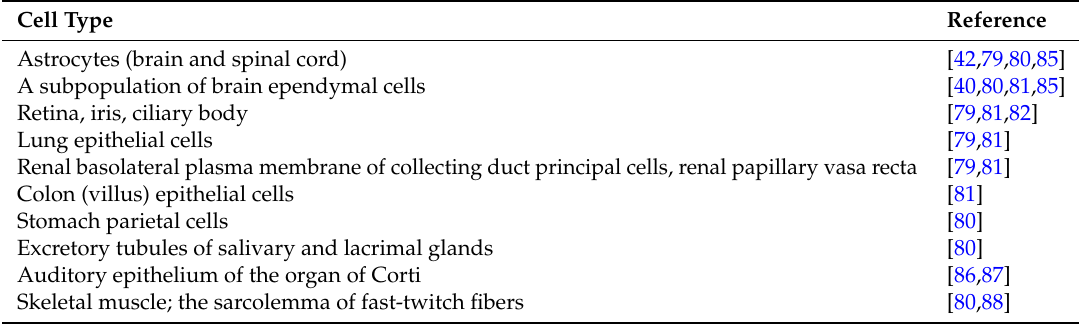
Table 3. The expression of AQP4 in different cells.